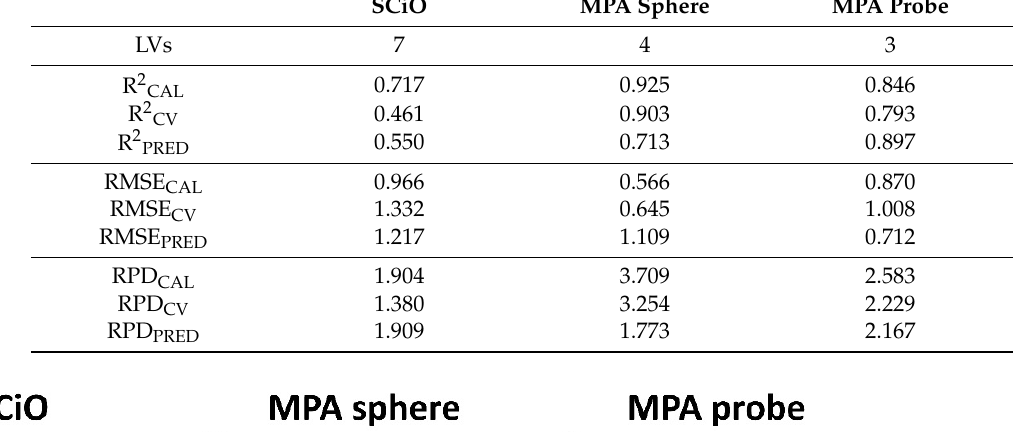
Table 1. Regression parameters from PLS models for the three NIR techniques. The three models have different complexities (number of latent variables, LVs), and the parameters used for describing the performances are the coefficient of determination (R 2 ) and the root mean squared errors (RMSEs). The subscripts stand for CAL = calibration, CV = cross validation, and PRED = prediction (test set). SCiO MPA Sphere